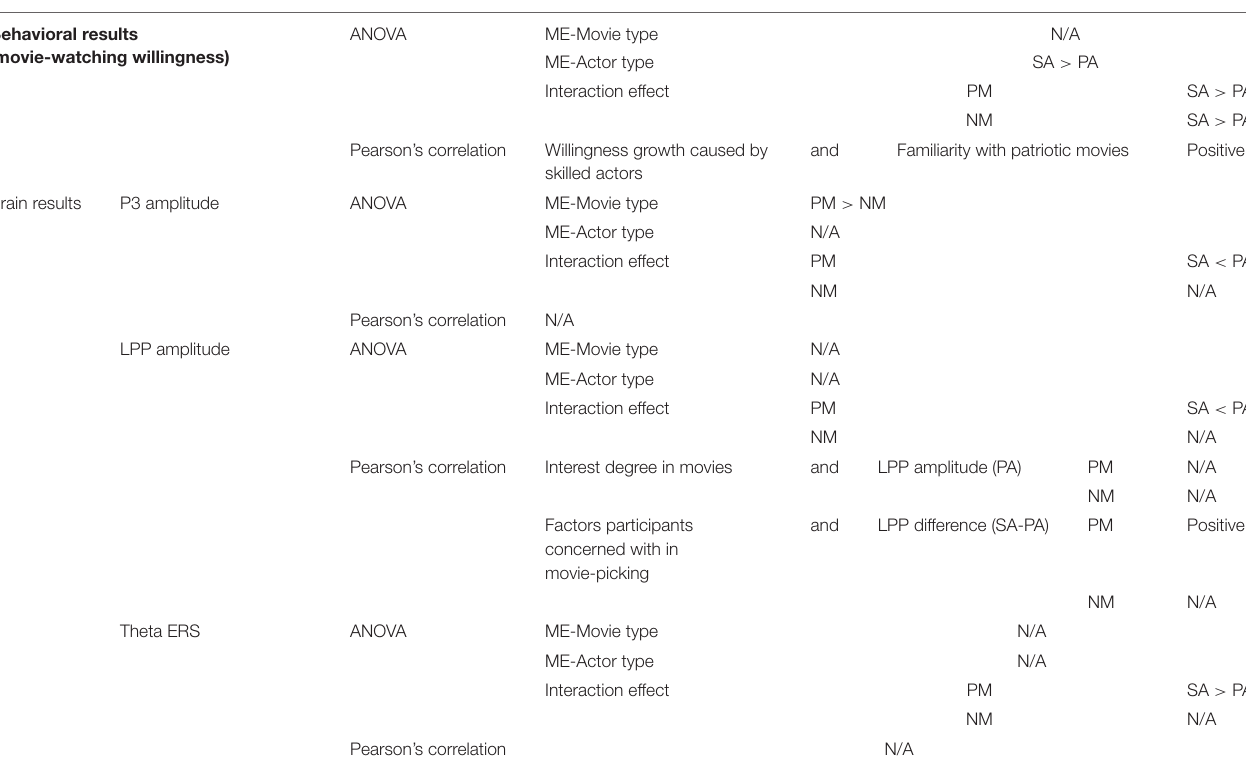
TABLE 1 | The behavioral and brain results. Behavioral results (movie-watching